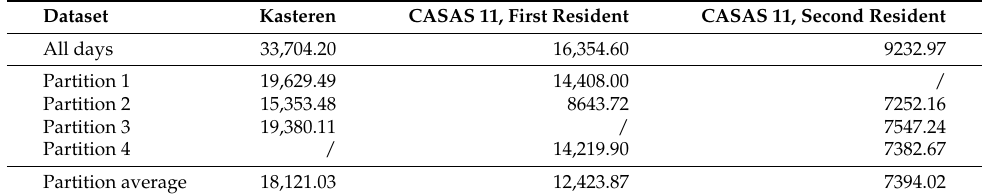
Table 4. Average Hamming distances H1 between all days and days in the same partitions.